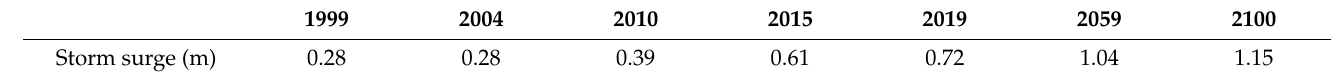
Table 6. Storm surges for the years of interest.